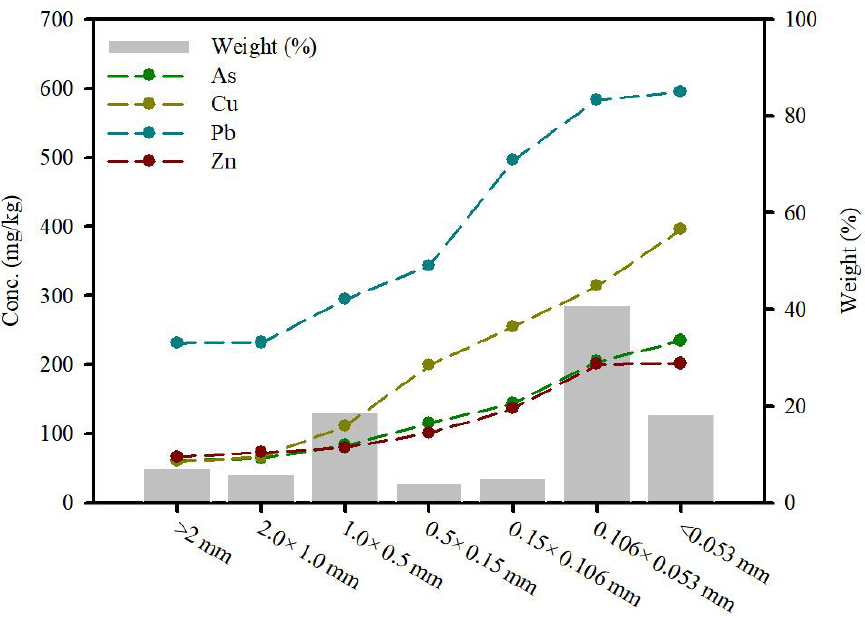
Figure 4. Concentration distribution of toxic heavy metals (mg/kg) and weight (%) according to particle particle size.